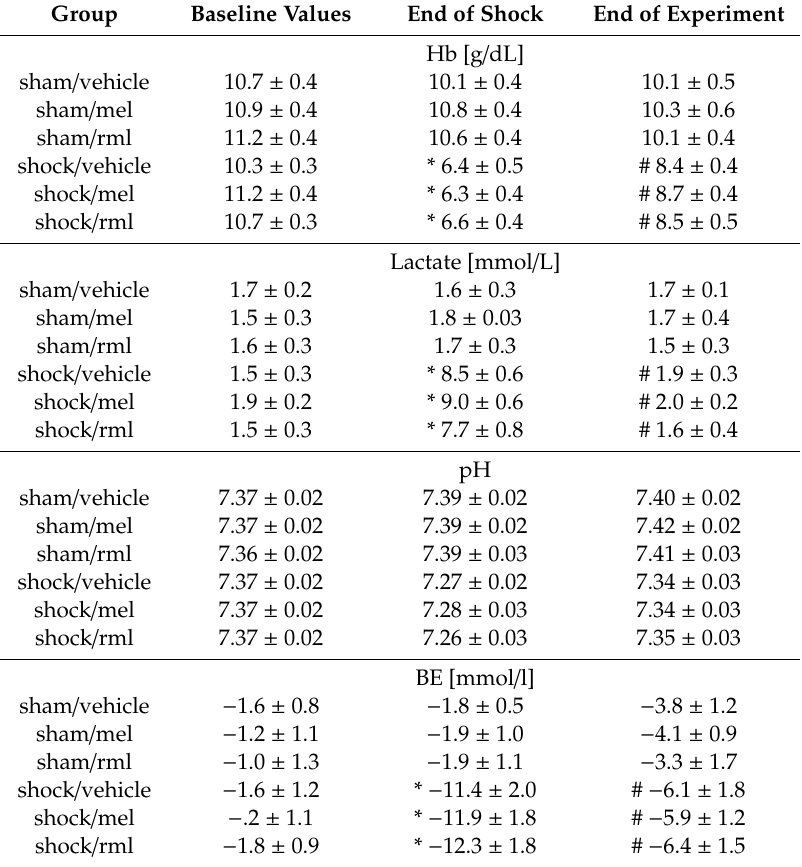
Table 1. Blood gas